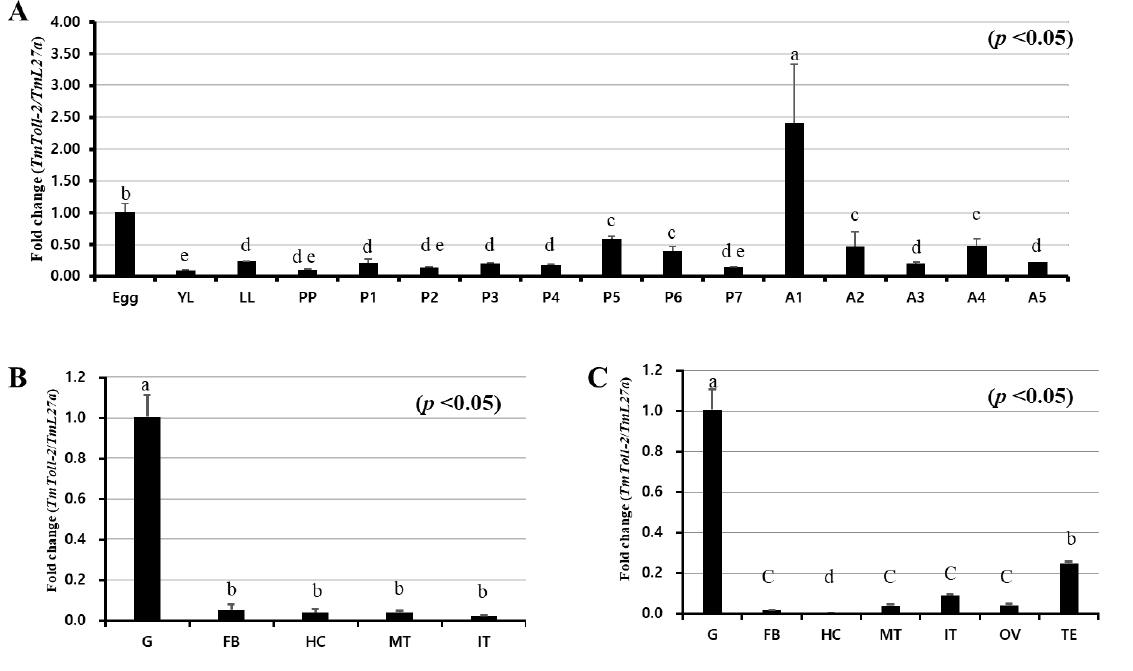
Figure 2. Developmental stage- and tissue-specific expression patterns of TmToll-2 measured by qRT-PCR. ( A ) Relative mRNA expression levels of TmToll-2 in eggs, young larvae, late-instar larvae (LL), pre-pupae, 1-to-7-day-old pupae (P1–P7), and 1-to-5-day-old adults (A1–A5) were presented. Expression levels were the highest in the eggs and 1-day-old adults. The mRNA expression decreased at the larval stage and were the lowest at the young larval stage. TmToll-2 tissue expression patterns in late instar larvae ( B ) and adults ( C ) were also examined. Total RNA was extracted from different tissues, including the integument (IT), Malpighian tubule (MT), gut (GT), hemocytes, and fat bodies (FB) of late instar larvae and the IT, MT, GT, hemocytes, FB, ovary, and testis (TE) of 5-day-old adults. Total RNA was isolated from 20 mealworms, and T. molitor 60S ribosomal protein 27a ( TmL27a ) primers were used as internal control (N = 3). One-way ANOVA and Tukey’s multiple-range test were used for comparisons. Bars with the same letter are not significantly different by Tukey’s multiple-range test ( p < 0.05).